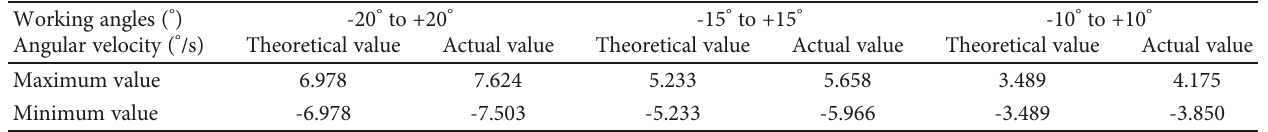
Table 6: The angular velocity characteristic value changes for the upper